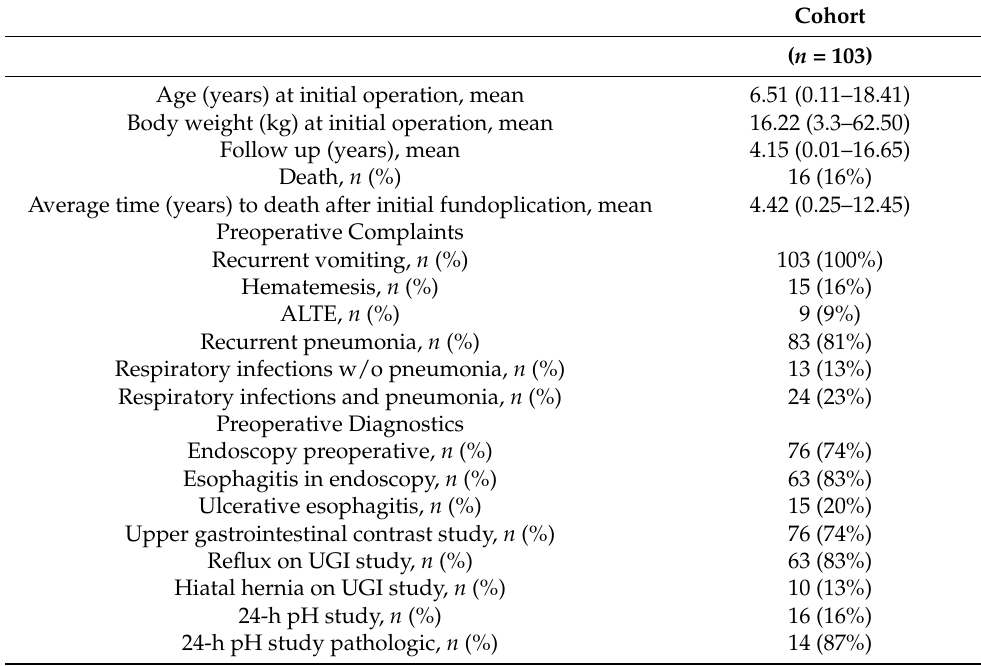
Table 1. Patient demographics, preoperative complaints, and preoperative diagnostics.